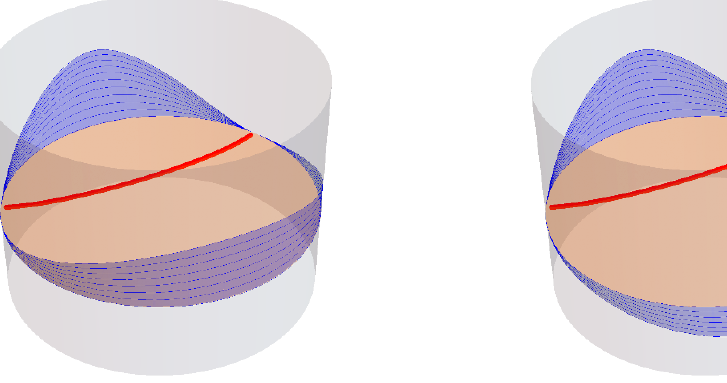
Figure 1 . A holographic representation of eqs. (2.1){(2.5): the global state W ij of a bipartite holographic CFT is prepared by a tensor network that (cid:12)lls a spatial slice of the bulk spacetime (orange). The division of the CFT is illustrated with a red line that cuts through the bulk. The panels show two general examples of ‘gauge transformations’ of ‘Wilson line’ W . The focus of this paper will be on those gauge transformations, which localize on HRRT